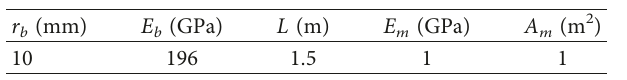
Figure 10: Influence of Young’s modulus of the confining medium on the peak load of rock bolts. Table 7: Mechanical properties of the bolt and the confining medium.